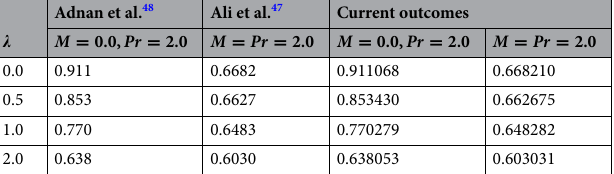
θ ′ ( 0 ) against various strength of (cid:31) at Ŵ −